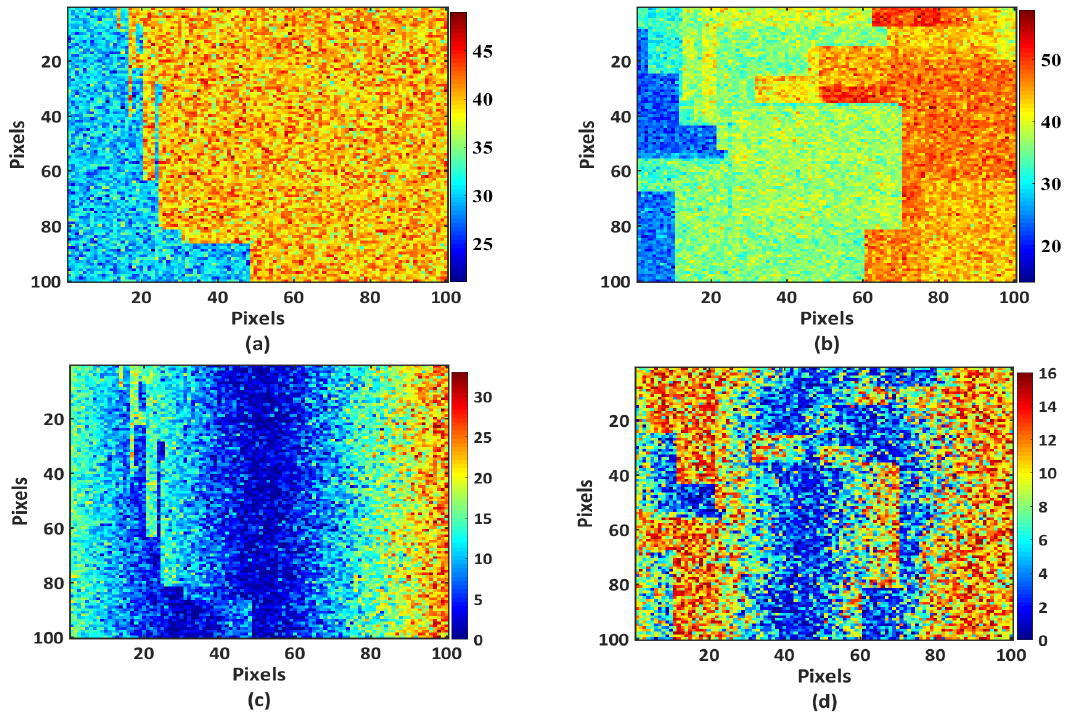
Figure 12. Visibility estimates after binning for the real dataset with 30 dB correlated ( a ) after the second iteration and ( b ) after fifth iteration; whereas ( c ) displays the pixelwise absolute differences between ( a ) with the true visibilities (Figure 10a) and ( d ) with those of ( b